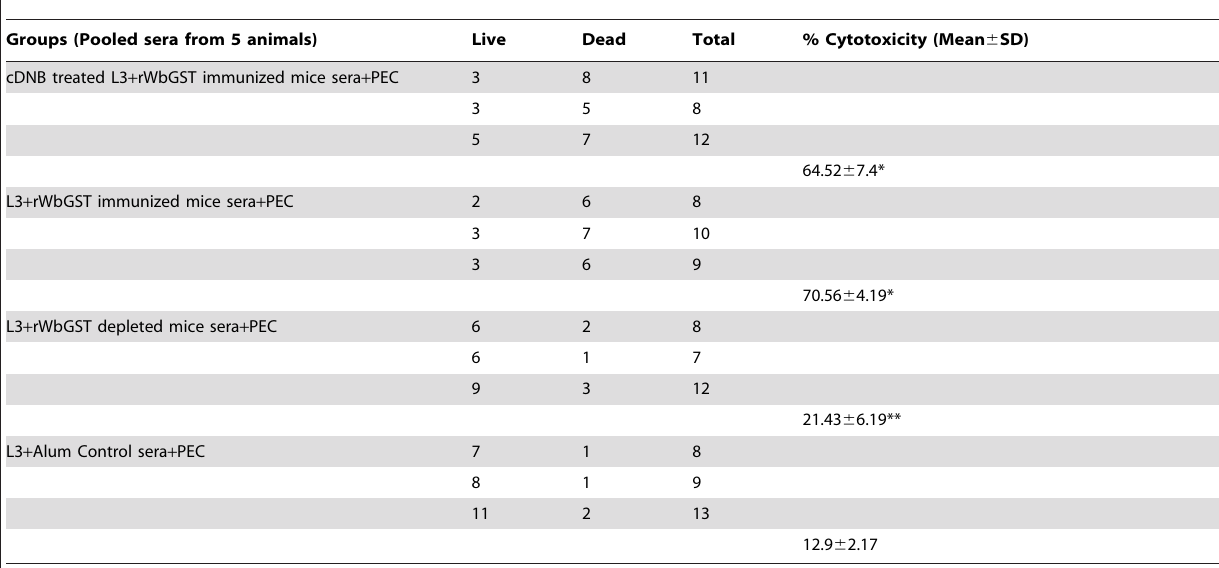
Table 1. Results of antibody-dependent cellular cytotoxicity (ADCC) assay against heterologous B. malayi L3.